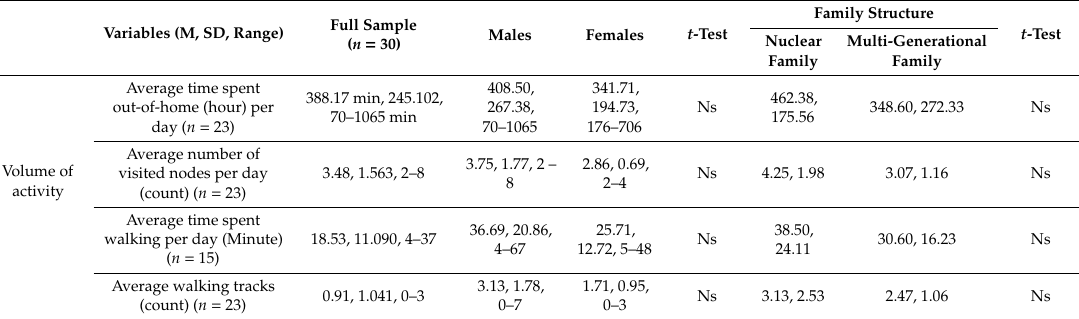
Table 3. Distribution of spatial variables (Volume of